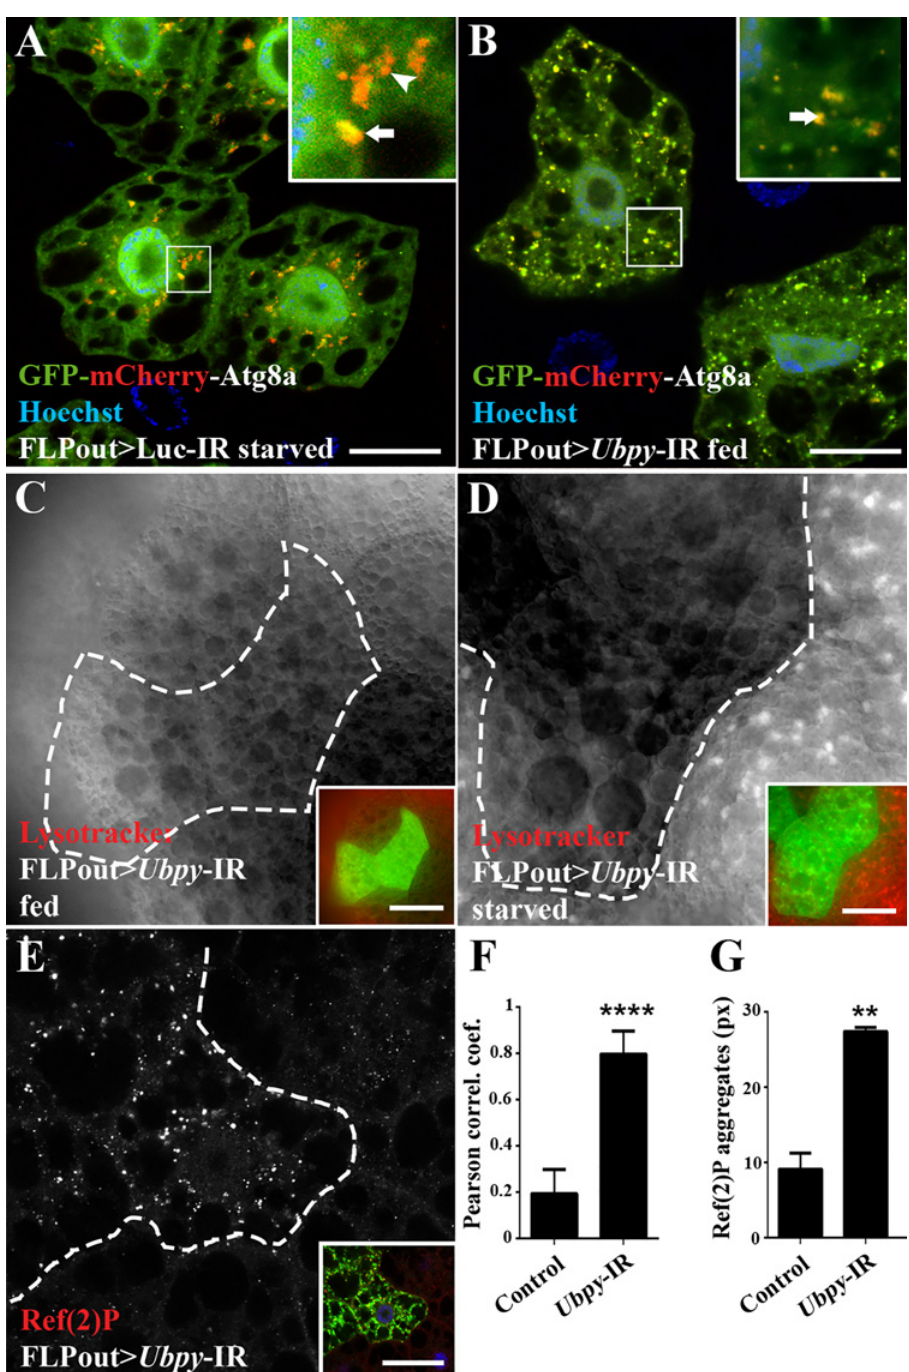
Fig 2. Ubpy loss-of-function blocks the autophagy flux. (A,B) Analysis of the autophagy flux using the tandem-tagged GFP-mCherry-Atg8a reporter in control cells from starved larvae (A) or in Ubpy silenced cells (B). Insets show an enlarged view for each condition (arrow: autophagosome, arrowhead: autolysosomes). Quantification of the colocalization of mCherry and GFP signals using the Pearson ’ s correlation coefficient is shown in F. (C,D) Lysotracker Red staining on fat bodies from fed (C) or starved (D) larvae silenced for Ubpy . Mutant cells were identified by the expression of the GFP-Atg8a marker (dotted lines and green channel in insets). (E) Confocal sections of larval fat bodies stained for the endogenous Ref(2)P protein. Mutant cells were identified by the expression of the GFP-Atg8a marker (dotted lines and green channel in insets). (G)